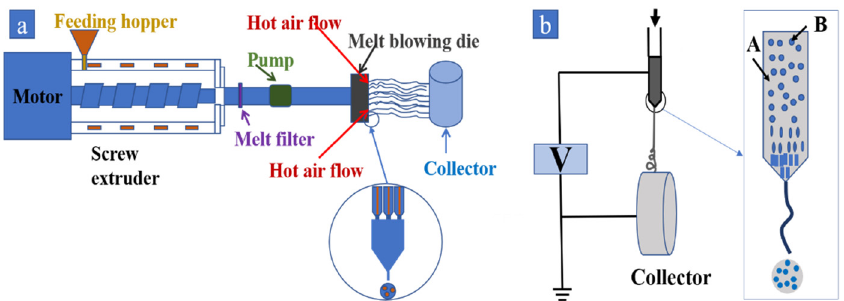
Figure 3: Schematic diagram of the preparation of islands - in - the - sea bi - component fi bers: ( a ) melt blowing and ( b ) electrospinning. ( a ) Adapted with permission ( 108 ) Copyright 2019, The Korean Fiber Society; ( b ) adapted with permission ( 109 ) Copyright 2007, American Chemical Society.